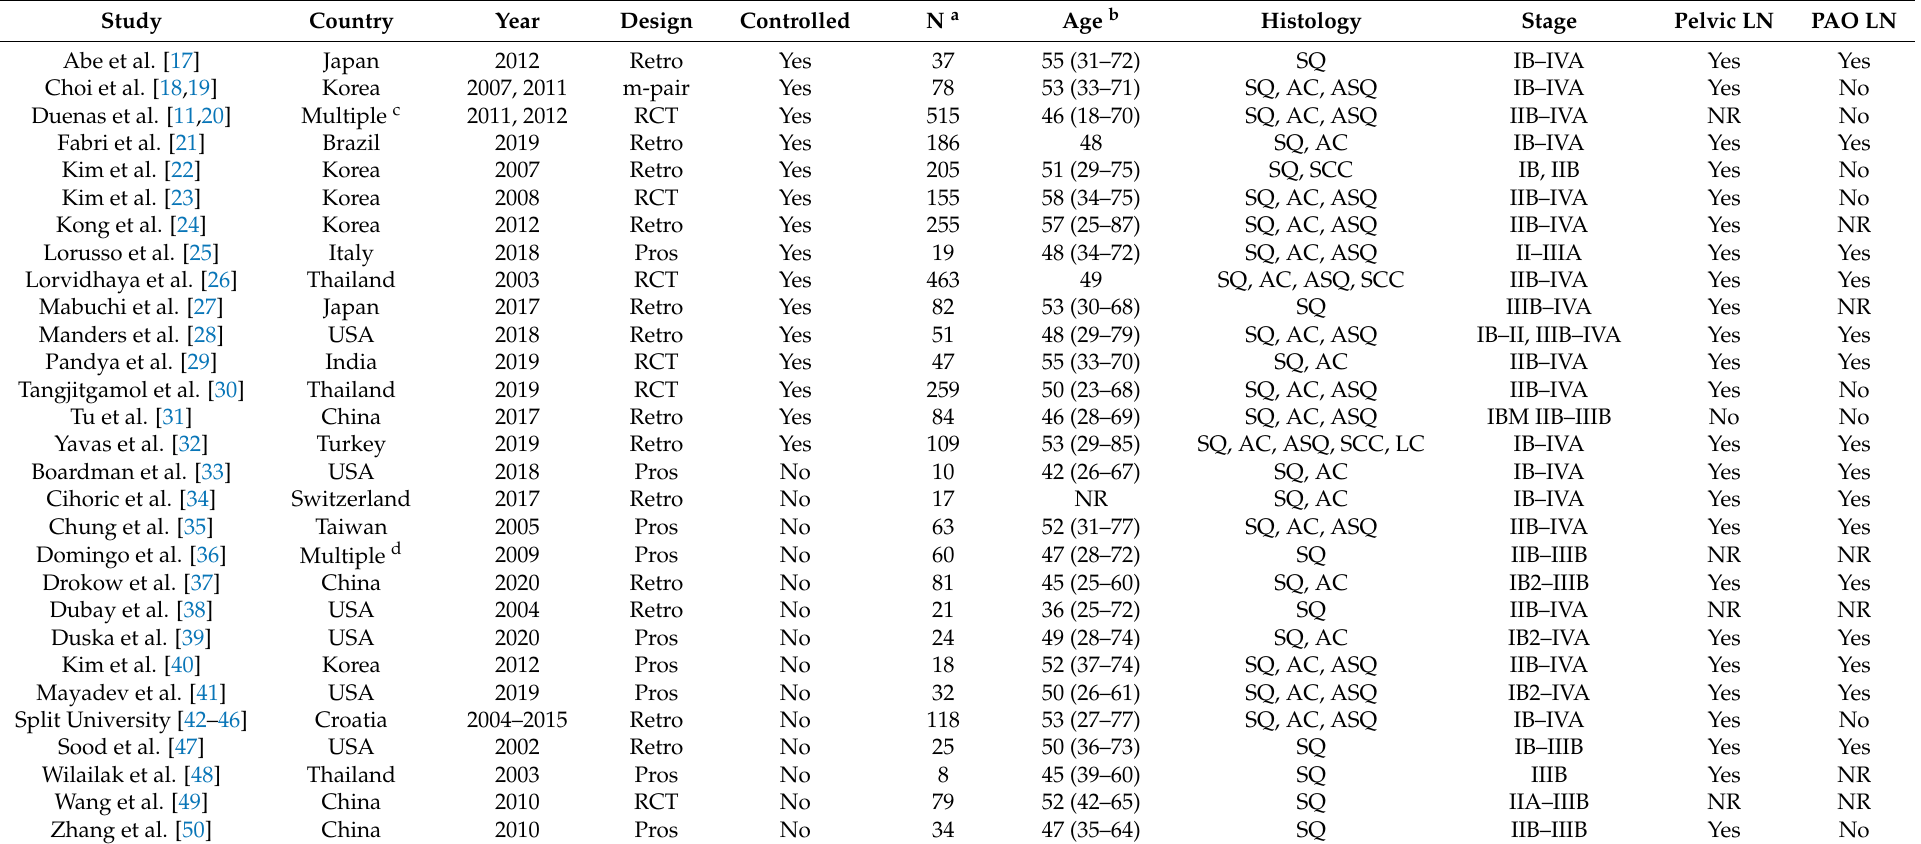
Table 2. Overview of the 29 included studies on adjuvant systemic therapy after chemoradiation and